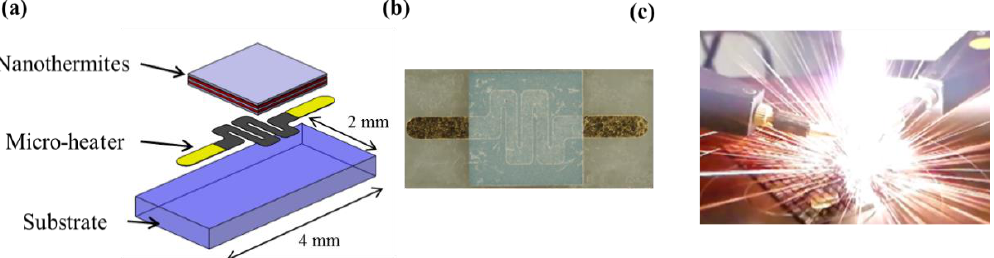
Figure 1. ( a ) A 3D schematic representation of a pyroMEMS used as an electric micro initiator, ( b ) a photo of the pyroMEMS, and ( c ) a photo taken during the nanothermite